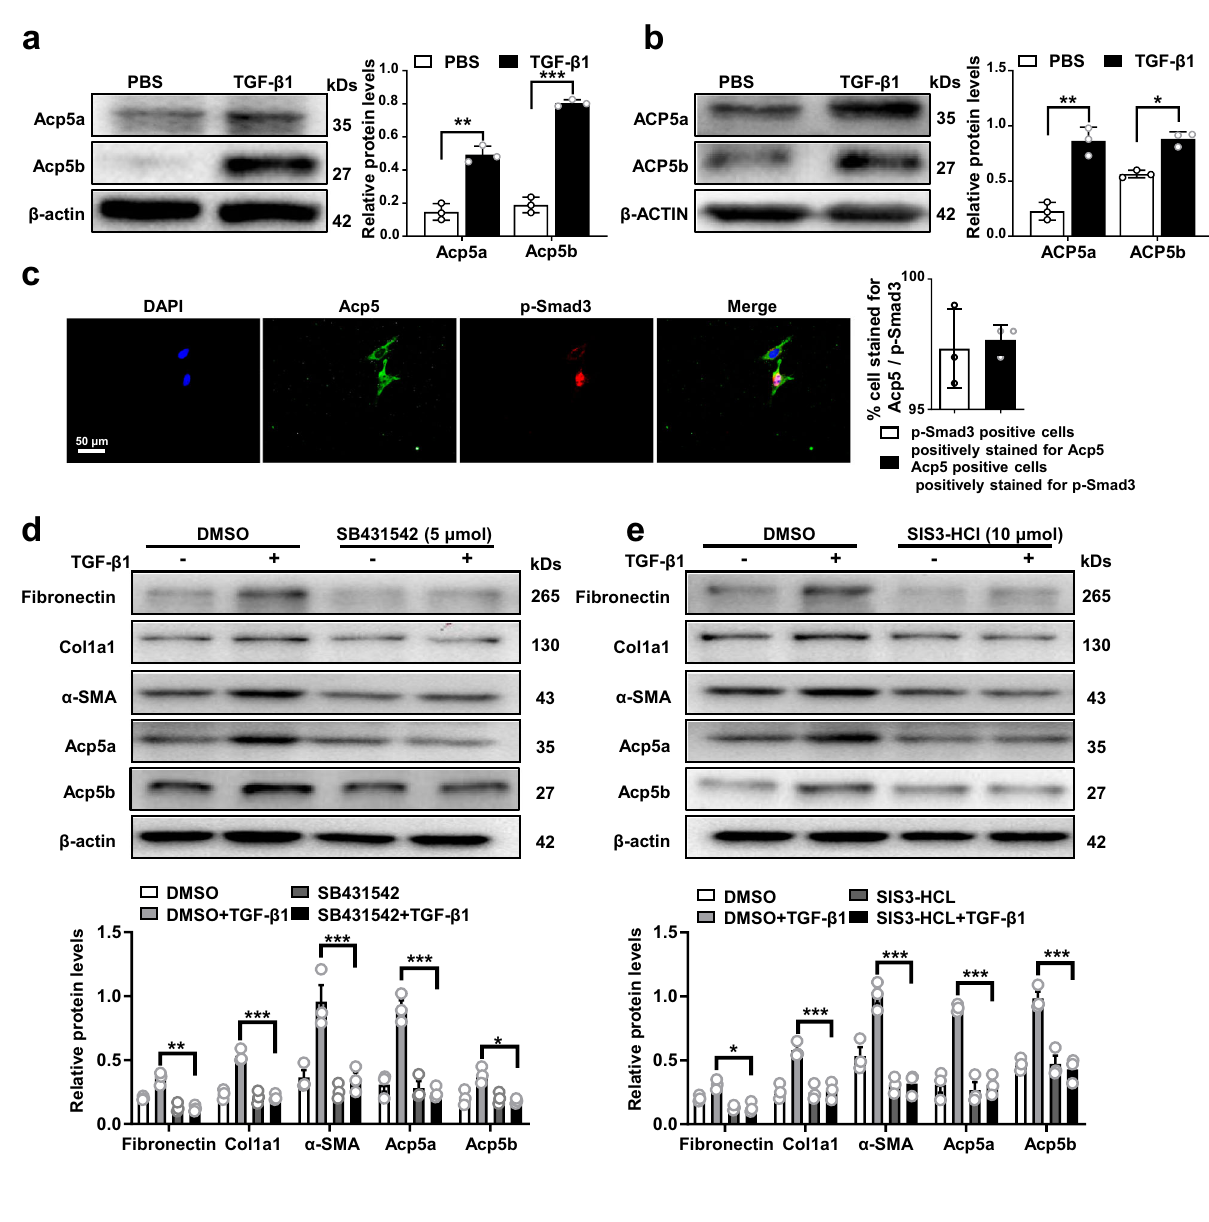
Fig. 2 Acp5 is upregulated in fi broblasts in a transforming growth factor β receptor 1 (TGF β R1) / Smad family member 3 (Smad3)-dependent manner. a Western blot analysis of Acp5a ( p = 0.0029) and Acp5b ( p = 0.0003) expression in primary mice lung fi broblasts (PMLFs) following TGF- β 1 induction. b Western blot analysis of ACP5a ( p = 0.0040) and ACP5b ( p = 0.0455) expression in primary human lung fi broblasts (PHLFs) following TGF- β 1 induction. c Representative results for coimmunostaining of Acp5 and p-Smad3 in PMLFs. The nuclei were stained blue by DAPI, and the images were taken under original magni fi cation ×400. d – e Western blot analysis of Fibronectin ( d : p = 0.0096, e : p = 0.0295), Col1a1 ( d : p = 0.0003, e : p < 0.0001), α - SMA ( d : p < 0.0001, e : p < 0.0001), Acp5a ( d : p < 0.0001, e : p < 0.0001) and Acp5b ( d : p = 0.02, e : p < 0.0001) expression in PMLFs following SB431542 ( d ) and SIS3-HCL ( e ) treatment. The data are represented as the mean ± SEM of three independent experiments and two-side Student ’ s t -test was administered to analyze the statistical signi fi cance of differences between two groups. * p < 0.05; ** p < 0.01; *** p < 0.001. Source data are provided as a Source Data fi